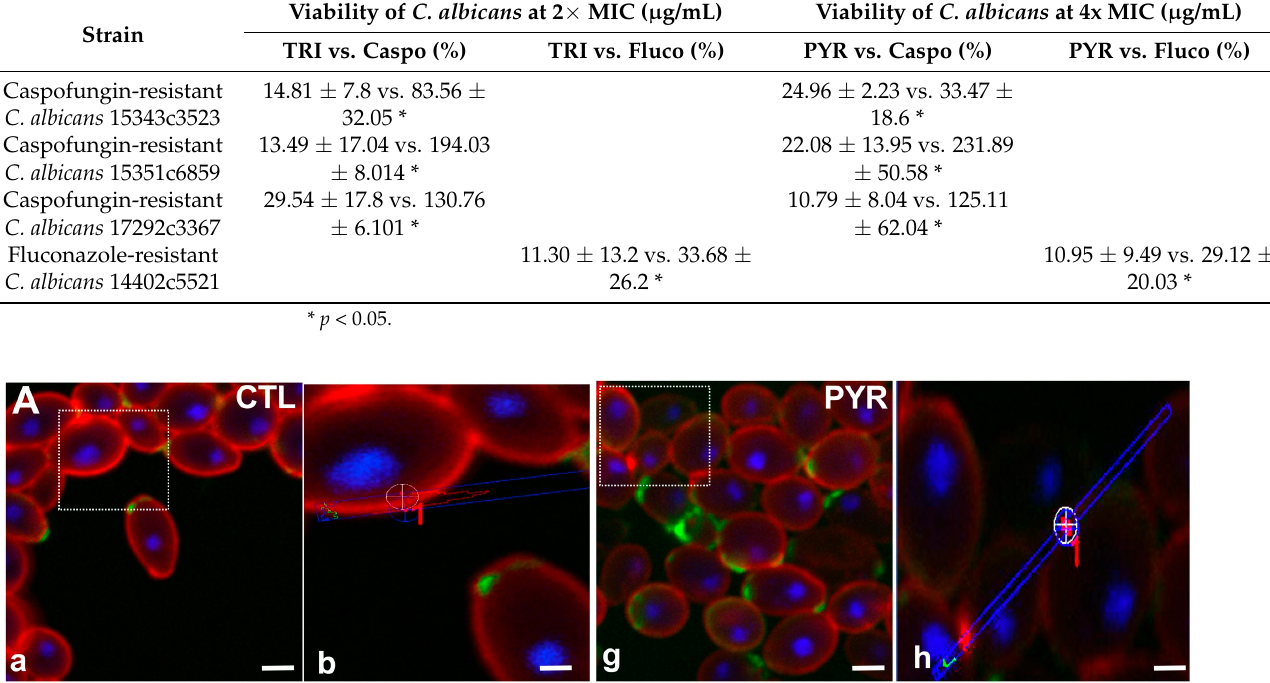
Table 3. Effect of PYR and TRI on the viability of drug-resistant C. albicans clinical isolates. Strain